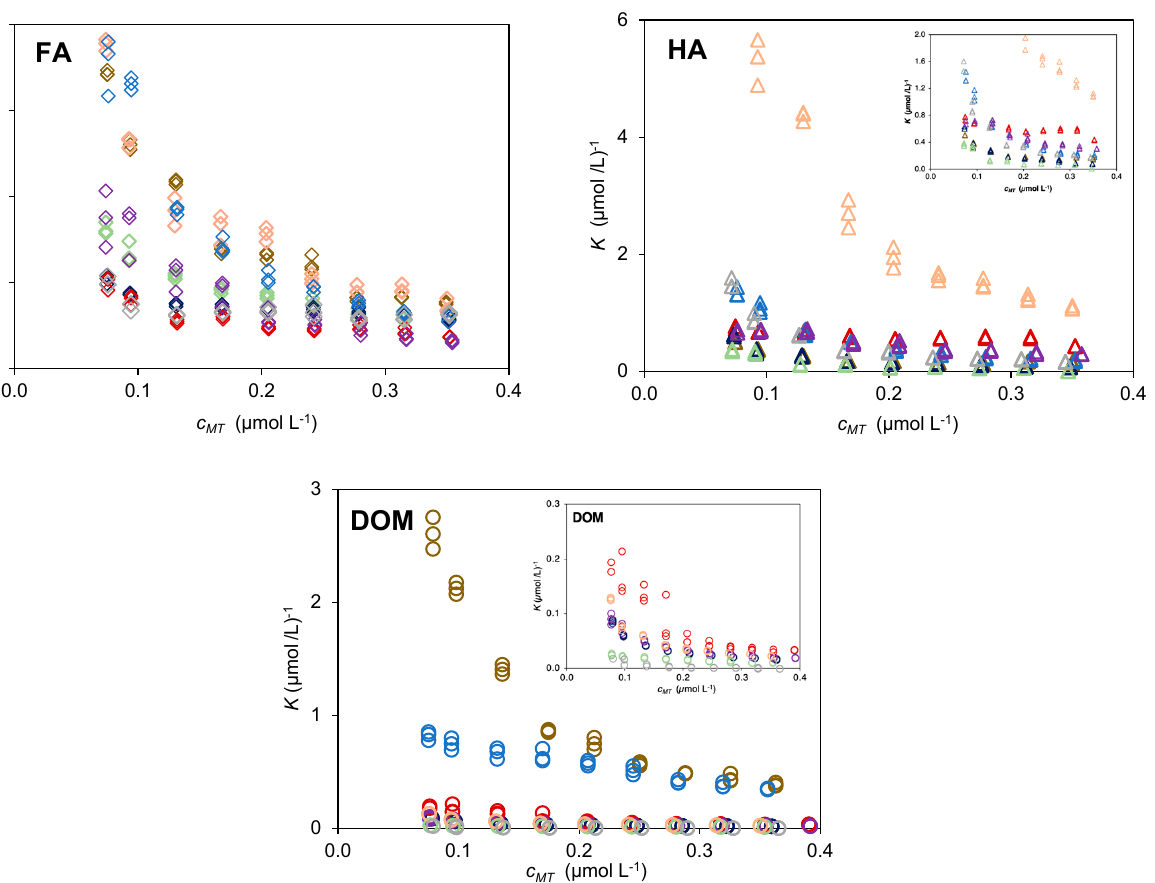
Figure 2. Experimental data expressed as complexation ratio, K , as a function of the total Cd 2+ concentration, c MT at pH 7.0 and ionic strength 12 mmol L − 1 in NaNO 3 and HNO 3 for FA, HA, and DOM extracted from: CDDW (purple), CVDW (red), CVA (green), CA (coral), CUW (blue), CSS (dark blue), CLW (brown), and of the fertiliser FLW (grey).